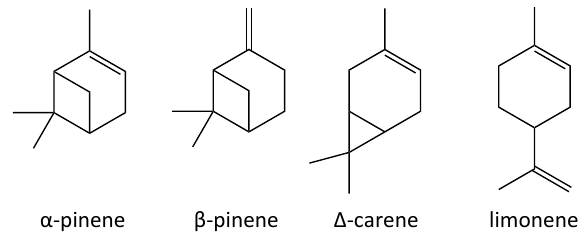
Figure 1. Structures of monoterpenes used in this